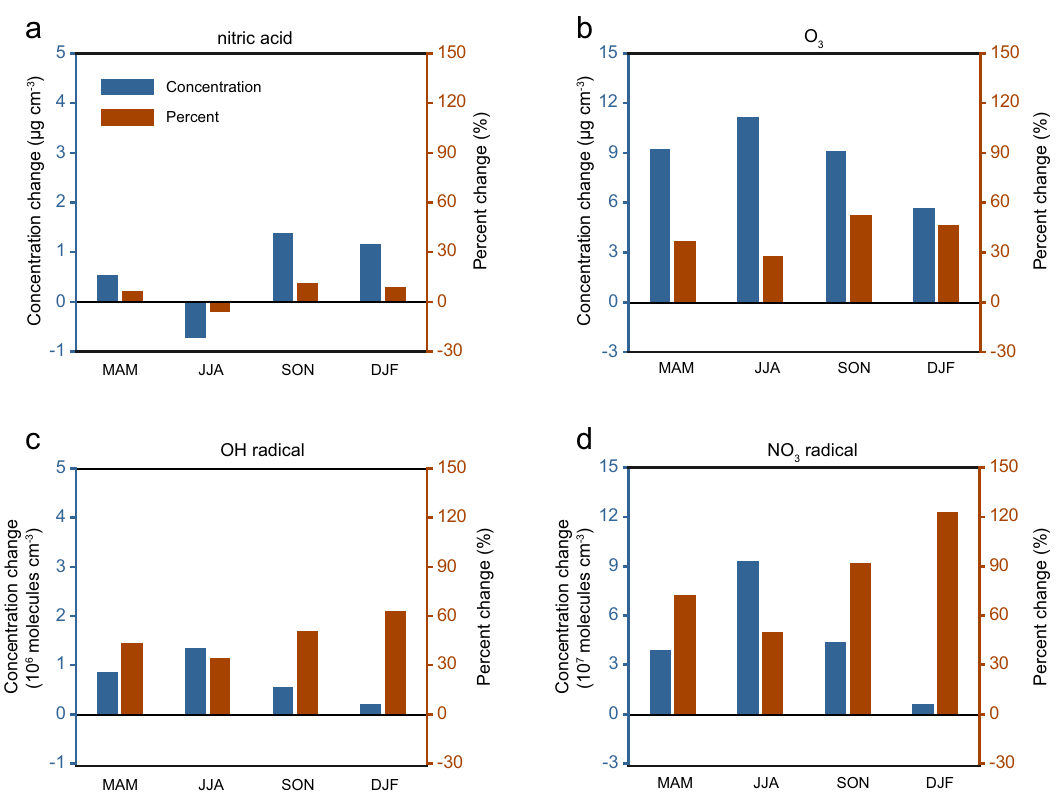
Fig. 3 Seasonal mean changes in near-surface nitric acid, O 3 , NO 3 radical, and OH radical concentrations in Eastern China caused by a 30% reduction of NO x emission. Both absolute and percent changes were calculated for a nitric acid concentrations, b O 3 concentrations, c OH radical concentrations, and d NO 3 radical concentrations. Results in four seasonal periods are shown here, i.e., MAM (March, April, and May), JJA (June, July, and August; local summer), SON (September, October, and November), and DJF (December, January, and February; local winter). The corresponding changes for Southern China are shown in Supplementary Fig.